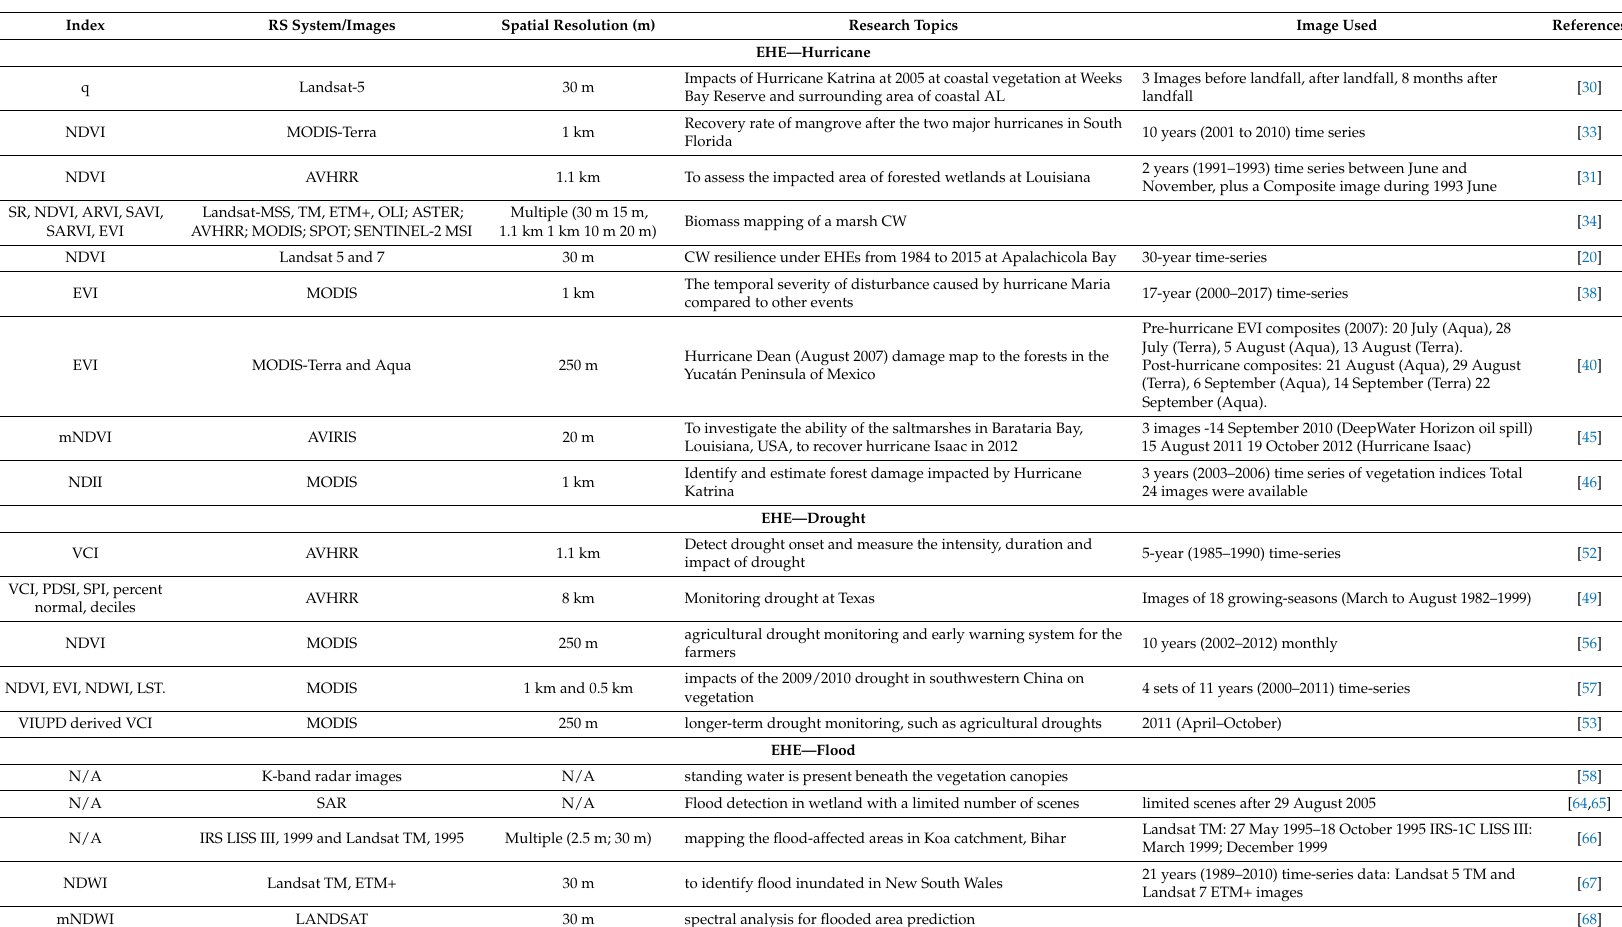
Table 2. List of remote sensing (RS) systems derived vegetation indices (VIs) used in past studies on coastal wetland (CW) resiliency under extreme hydrologic events (EHEs) driven